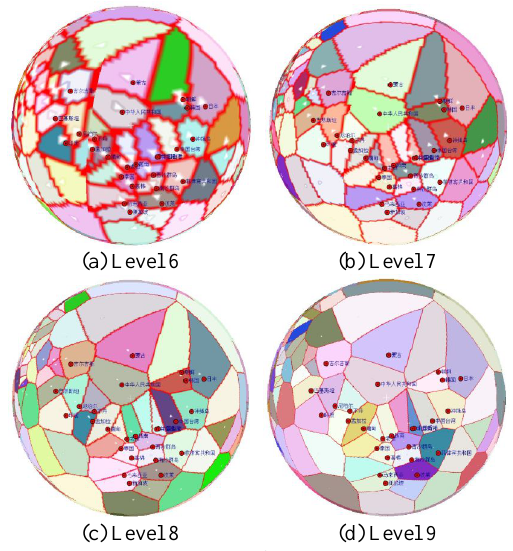
Figure 7. Voronoi diagrams of all the countries in the word The Voronoi boundary extraction algorithm is also tested in our experiments. Figure 8 shows the Voronoi boundaries of point sets, line sets, area sets and the composite of all the three types of sites in Level 9. The blue objects are the input sites and the red lines are the Voronoi boundaries of the sites.